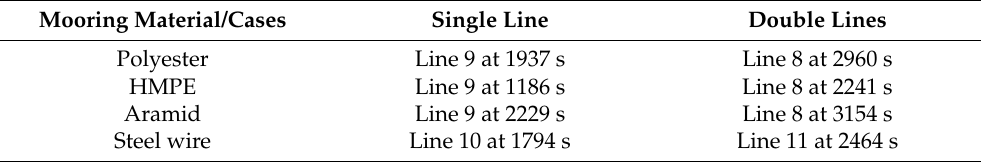
Table 6. Mooring failure